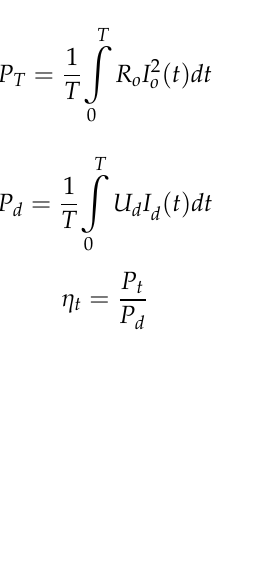
Figure 8. The 3D plot of the resultant coupling capacitance C s as a function of the relative position.